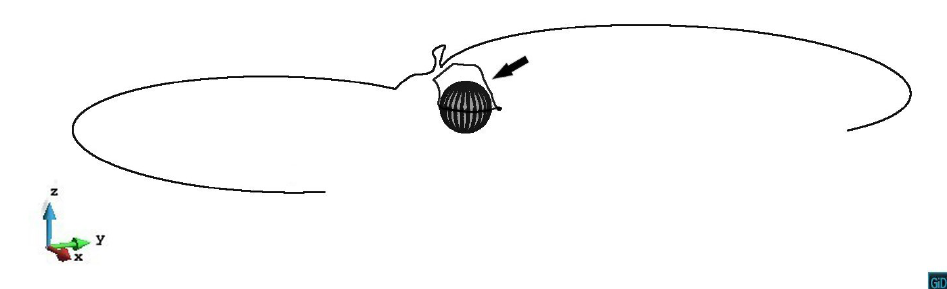
Figure 4. The dislocation line in z / R = 0.2 case bypassing the precipitate with a prismatic loop (black arrow) left. The plastic strain ε = 1.69 × 10 − 4